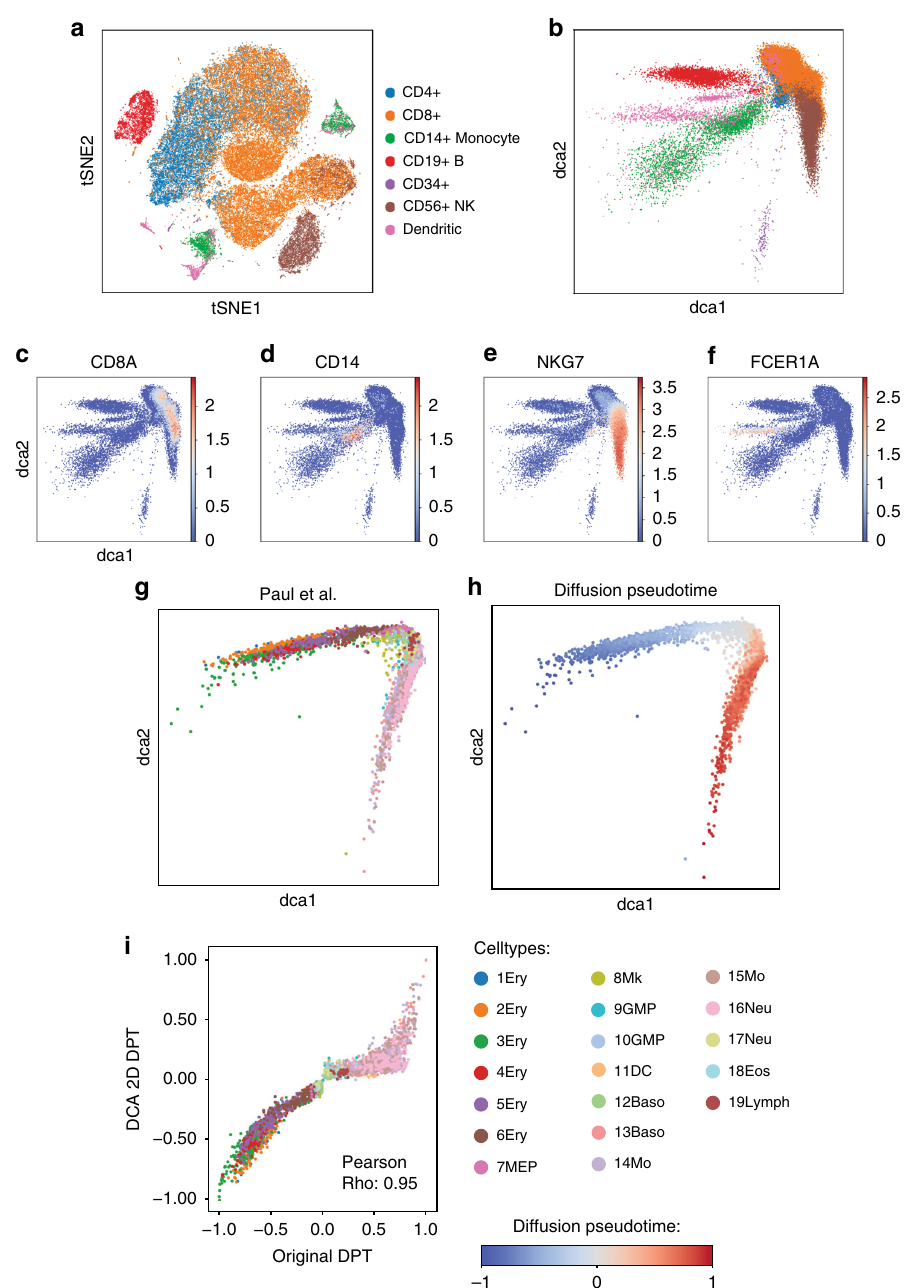
Fig. 3 DCA captures population structure in 68,579 peripheral blood mononuclear cells. a shows the tSNE visualization reproduced from Zheng et al. 12 . b illustrates the activations from the two-dimensional bottleneck layer of the DCA. Colors represent celltype assignment from Zheng et al. 12 , where CD4 + and CD8 + cells are combined into coarse groups. Silhouette coef fi cients are − 0.01 and 0.07 for tSNE and DCA visualizations. c – f show two-dimensional bottleneck layer colored by the log-transformed expression of celltype marker genes CD8A (CD8 + T cells), CD14 (CD14 + Monocytes), NKG7 (CD56 + natural killer cells) and FCER1A (dendritic cells), respectively. DCA derived manifold robustly reconstructs continuous differentiation phenotype. g , h illustrate the activations from the two-dimensional bottleneck layer of DCA colored by celltype assignment from Paul et al. ( g ) and diffusion pseudotime ( h ), respectively. i shows the DPT as calculated using the standard DPT work fl ow and the two-dimensional bottleneck layer coordinates on the X and Y axis, respectively. Cells are colored by celltype assignment from Paul et al. 35 . Abbreviations Ery, Mk, DC, Baso, Mo, Neu, Eos, Lymph correspond to erythrocytes, megakaryocytes, dendritic cells, basophils, monocytes, neutrophils, eosinophils and lymphoid cells, Denoising improves differential expression analysis . Motivated his-8 is depicted in Fig. 4e, f, g, respectively. Expression data by the scRNA-seq denoising evaluation metrics proposed by Li derived from denoising using MAGIC, SAVER and scImpute for et al. 22 , we compared differential expression analysis results these two genes is displayed in Supplementary Fig. 4. tbx-36 and his-8 represent transcription factor and histone gene classes, between bulk and scRNA-seq data from the same experiment. respectively, which are known to show opposing expression patterns during C.elegans development 38 .